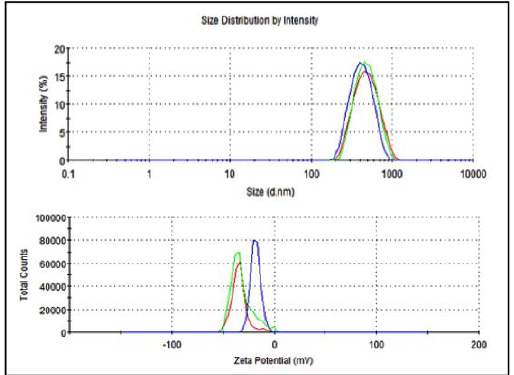
Figure 2. Particle size and zeta potential distribution of nanoemulsified vit-A by intensity using dynamic light scattering correlation spectroscopy. The average particle size of nanoemulsified vit-A was around 475.7 nm, and the zeta potential of nanoemulsified vit-A was around − 33.5 mV. The polydispersity index (PDI) value of the nanoemulsified vit-A was 1.70.